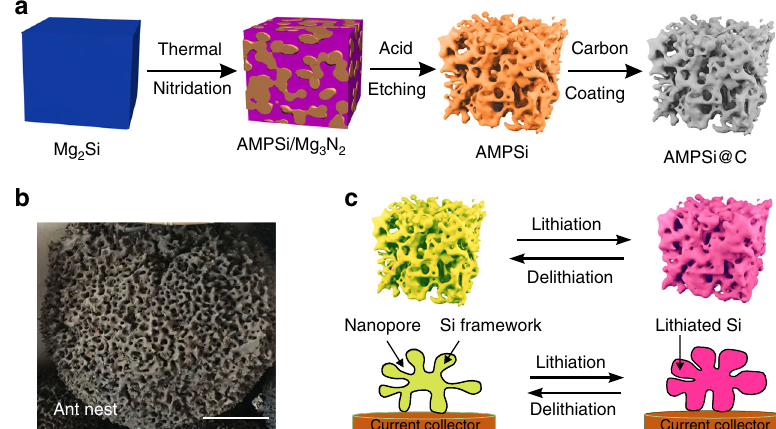
Fig. 1 Design and schematic showing the synthesis method of AMPSi. a Schematic showing the preparation of AMPSi and AMPSi@C. b Photograph of an ant nest (scale bar = 20 cm). c Schematic illustrating the lithiation/delithiation process of the ant-nest-like microscale porous Si particles showing inward volume expansion and stable Si framework retention during